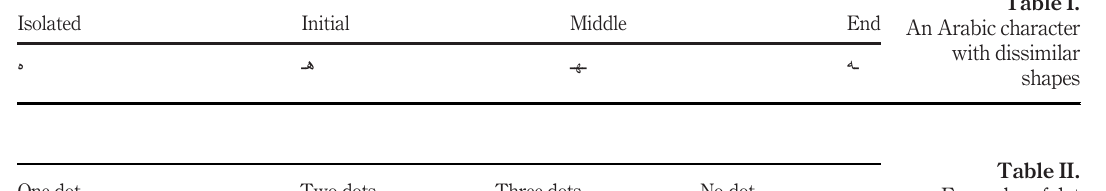
Table II. Examples of dot